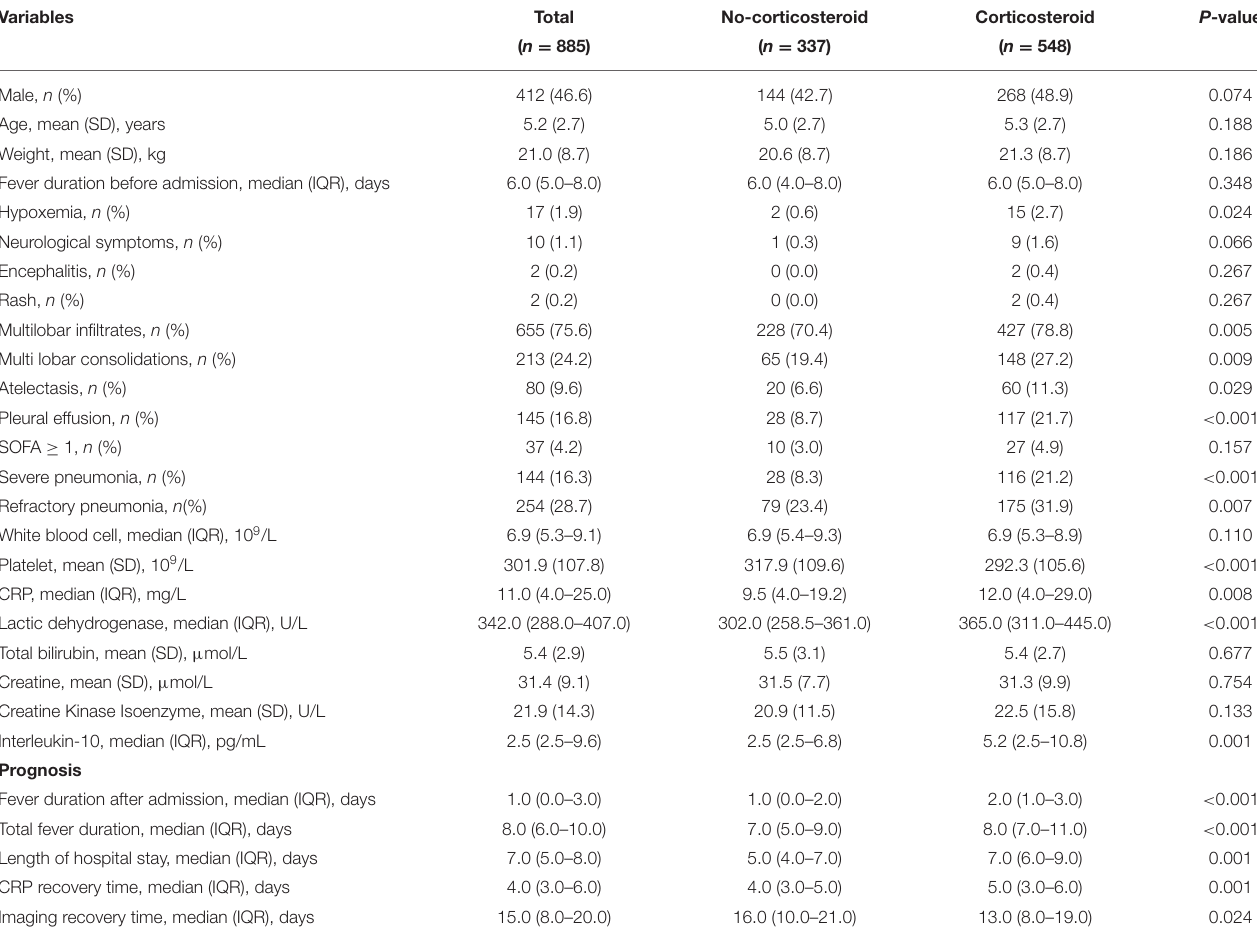
TABLE 1 | Characteristics of children with Mycoplasma pneumoniae pneumonia stratified by adjunctive corticosteroid treatment.